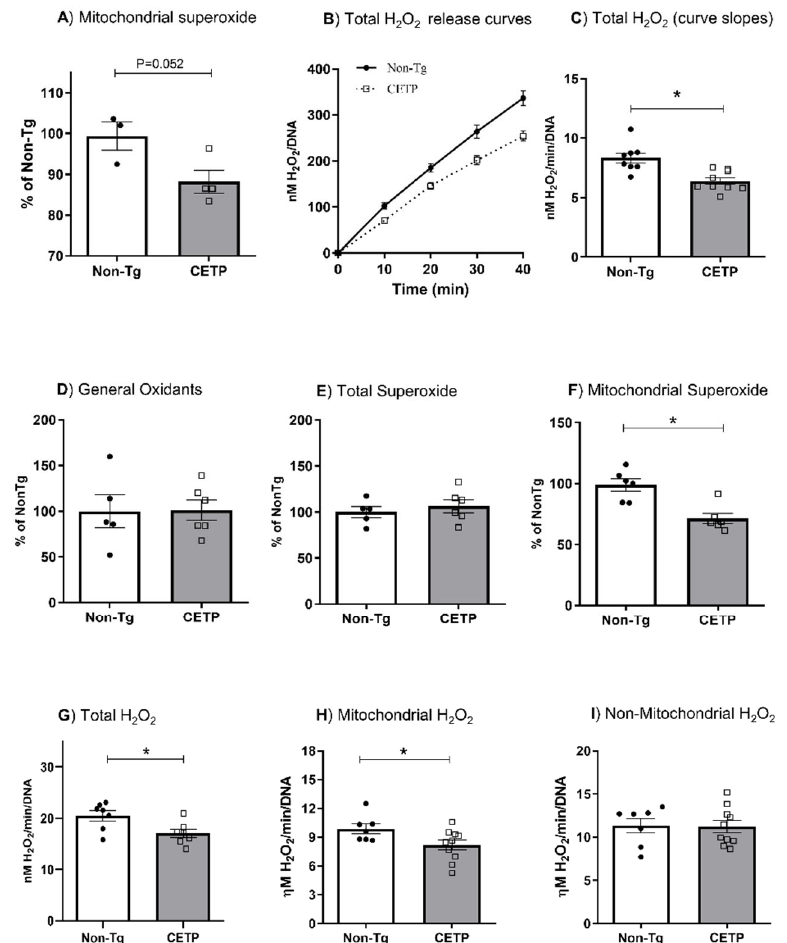
Figure 1. CETP expression in macrophages decreases mitochondrial oxidant production. Oxidant pro- duction in resting resident ( A – C ) and thioglycolate-elicited ( D – I ) peritoneal macrophages from human CETP transgenic and non-transgenic mice (Non-Tg). ( A ) Mitochondrial superoxide anion production; ( B ) H 2 O 2 release curves; ( C ) H 2 O 2 release rates (curve slopes from B); ( D ) global oxidant production; ( E ) total cell superoxide; ( F ) mitochondrial superoxide anion; ( G ) total H 2 O 2 ; ( H ) mitochondrial H 2 O 2 and ( I ) non-mitochondrial H 2 O 2 release rates. Non-mitochondrial H 2 O 2 contribution was determined in cells treated with carbonyl cyanide-p-trifluoromethoxyphenylhydrazone (FCCP) (1 µ M) and mito- chondrial derived H 2 O 2 was calculated as (total - non-mitochondrial H 2 O 2 ). * p <